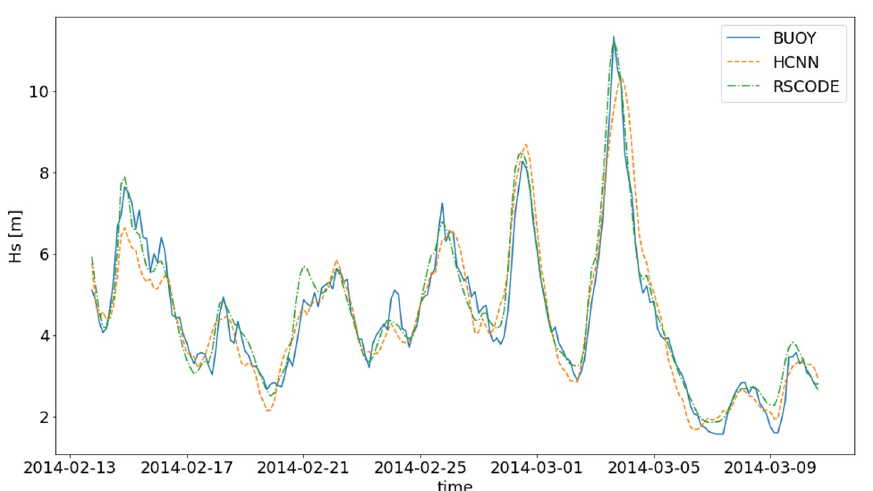
Figure 10. (a) Scatterplot. (b) Quantile–Quantile plot.